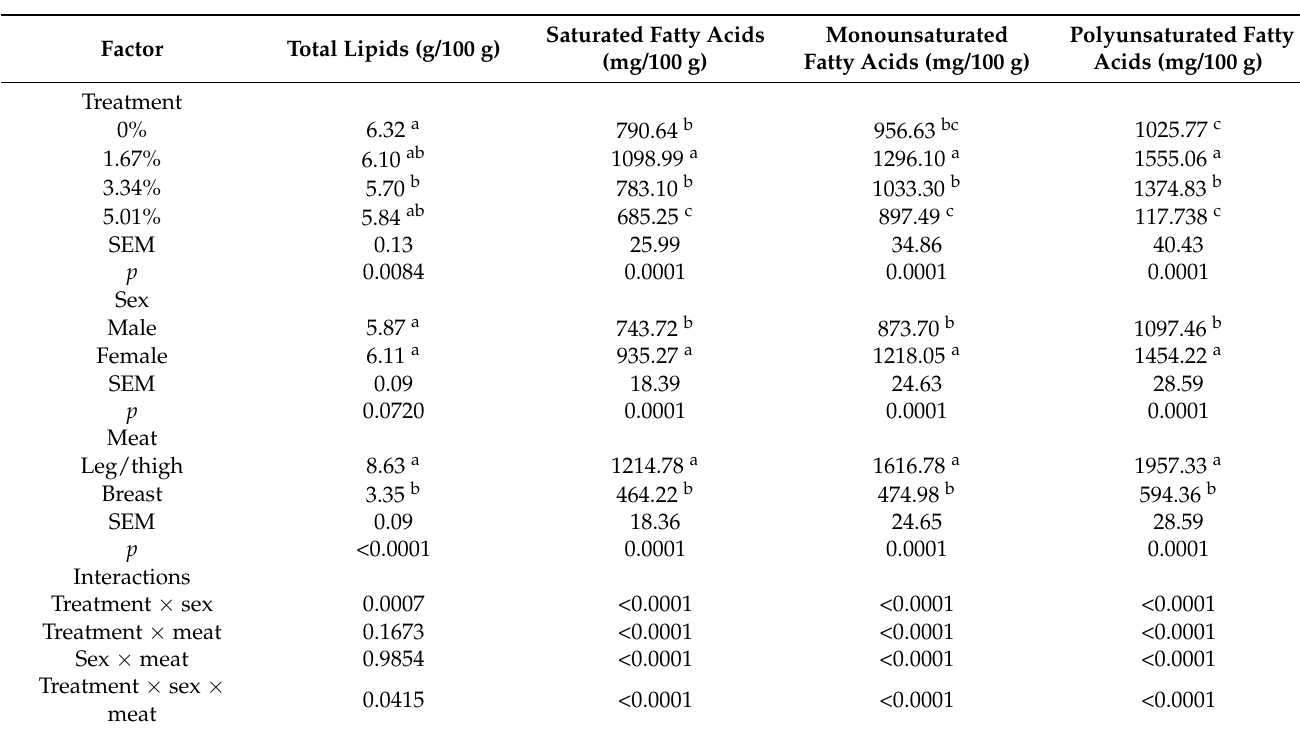
Table 3. Effect of treatment, sex, and meat on the content of total lipids and saturated, monounsatu- rated, and polyunsaturated fatty acids when incorporating giant squid ( Dosidicus gigas ) meal into the diet of the broilers.